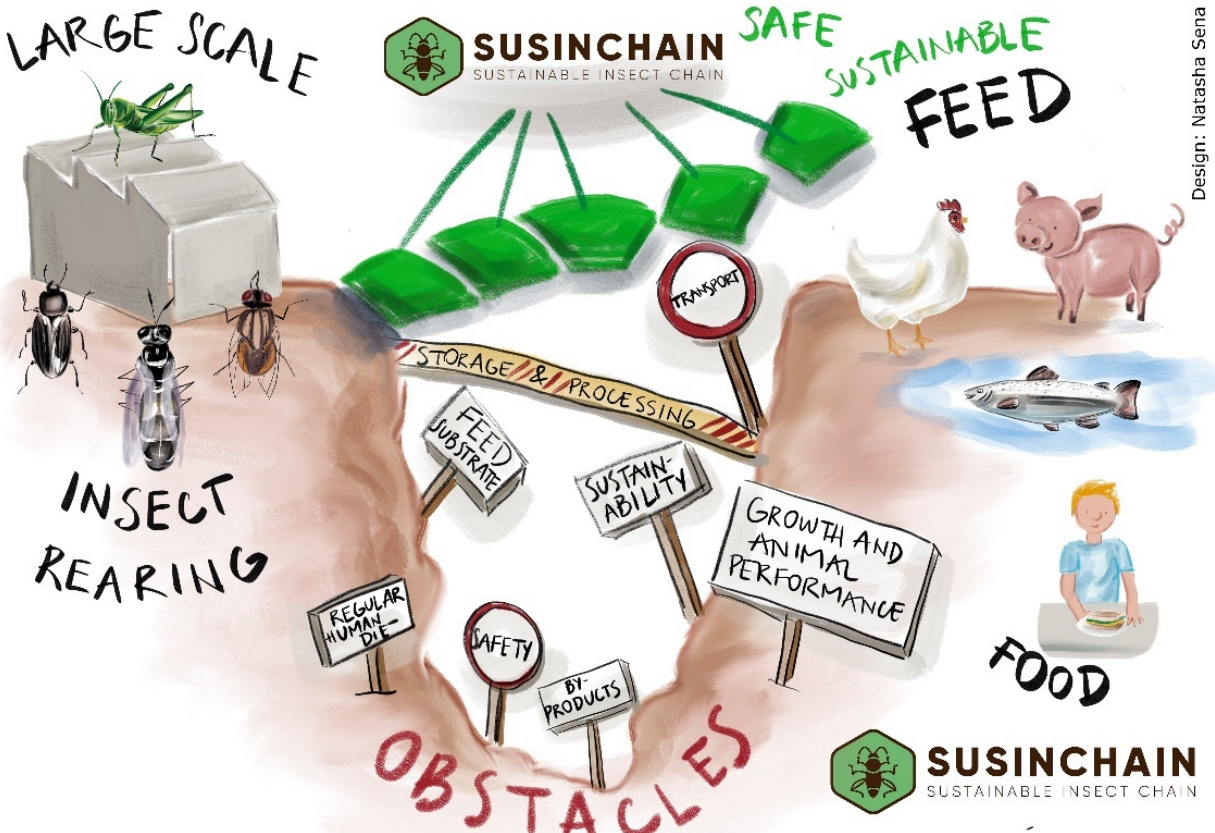
Figure 1. Challenges to be addressed to fill the gap between insect protein demand and supply.